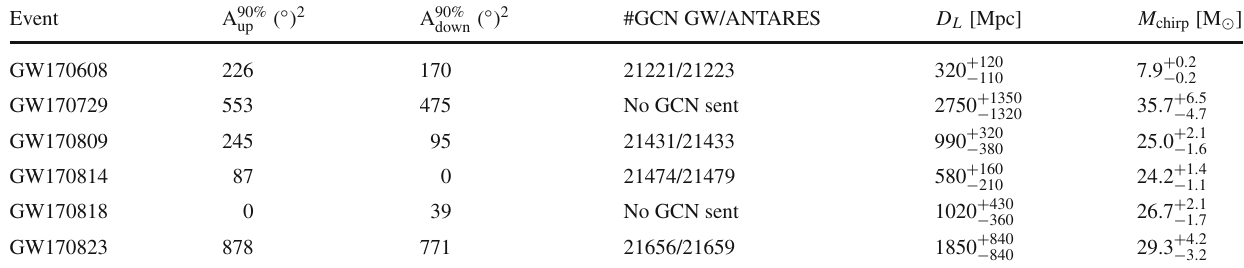
Table1 PropertiesofthesixGWeventsanalysedinthiswork.Thesize of the 90c CL error box viewed as downgoing and upgoing events for ANTARES at the time of the alert is provided in the first two columns. The GCN circular numbers associated with the Advanced LIGO-Virgo